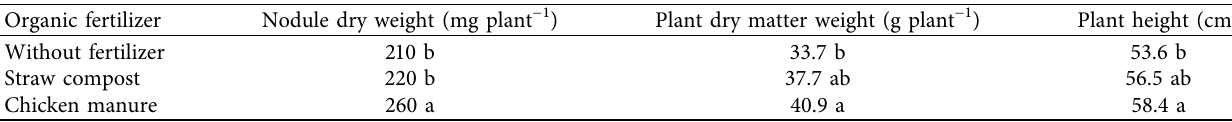
Table 1: Effect of organic fertilizer applied in the rainy season on nodule dry weight, plant dry matter, and plant height of soybean in the first dry season.